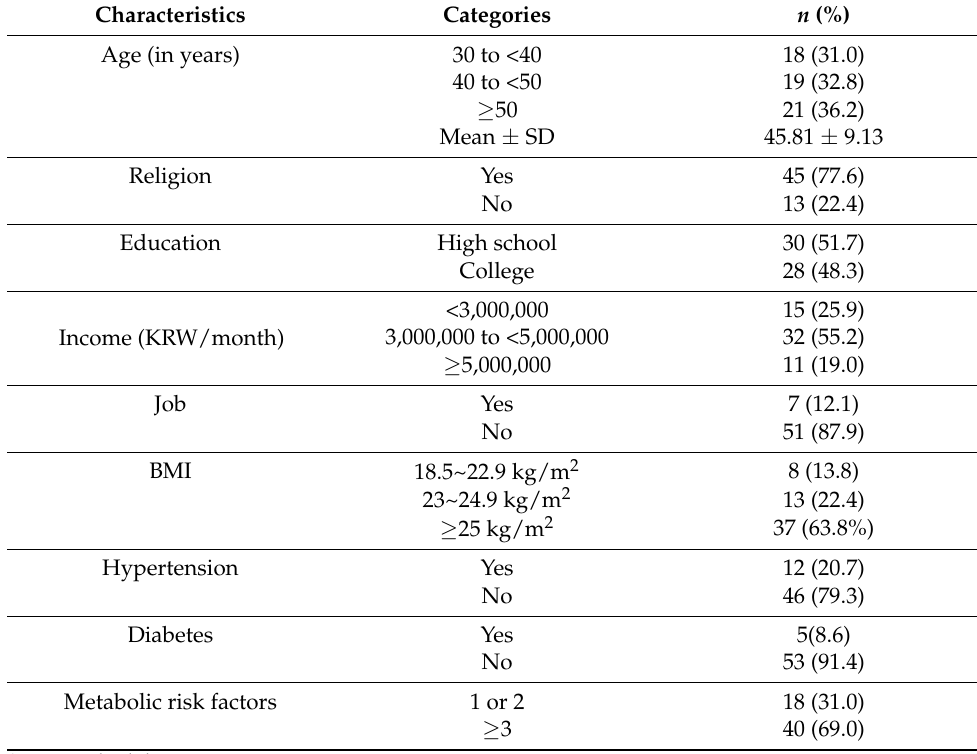
Table 2. Demographic and metabolic-related characteristics of the study population ( N = 58).